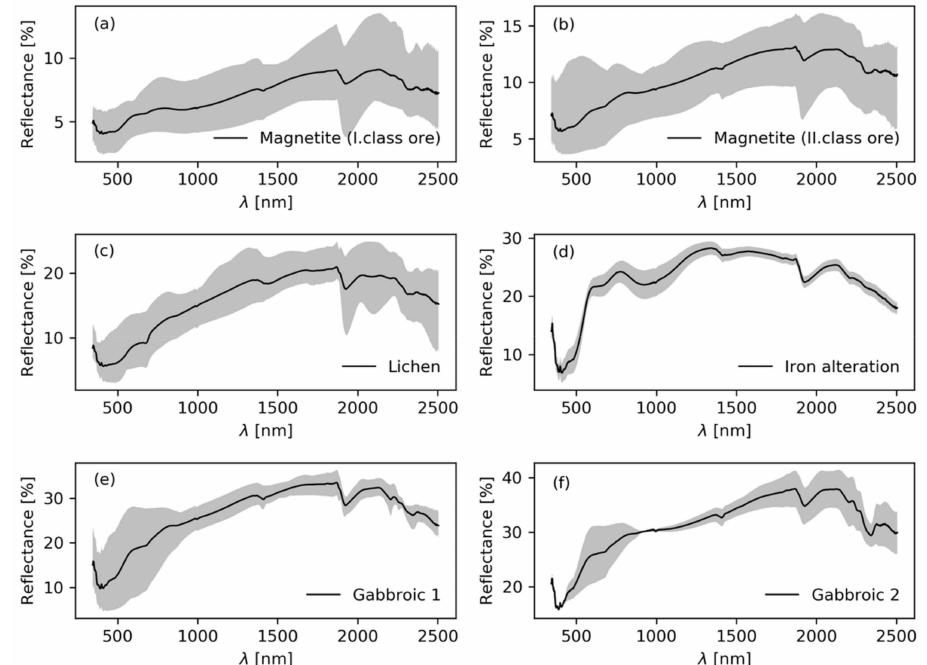
Figure 10. Results of the acquired handheld spectra after sorting them by unsupervised clustering. The clusters were attributed to magnetite, iron alteration, gabbroic rock, and lichen using k-means with six input classes, and refined together with field observations at the scanned spots. Calculated mean spectra are indicated as black lines and the minimum and maximum spectral values are described by the grey